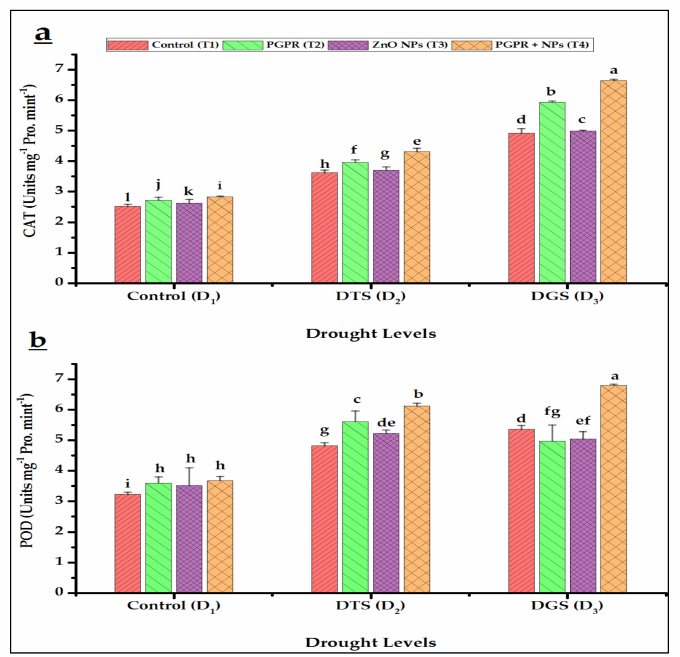
Figure 6. Effects of Azospirillum brasilense and ZnO NPs on wheat catalase ( a ) and peroxidase ( b ) activities under drought conditions. DTS = drought at tillering, DGS = drought at grain filling, T 1 = control, T 2 = single use of Azospirillum brasilense , T 3 = single use of ZnO NPs, and T 4 = co-application of PGPR and NPs. Error bars indicate standard error ( n = 3). (Note: Differ- ent lowercase letters indicate significant differences between different drought levels and treatments by the LSD test at p < 0.05).